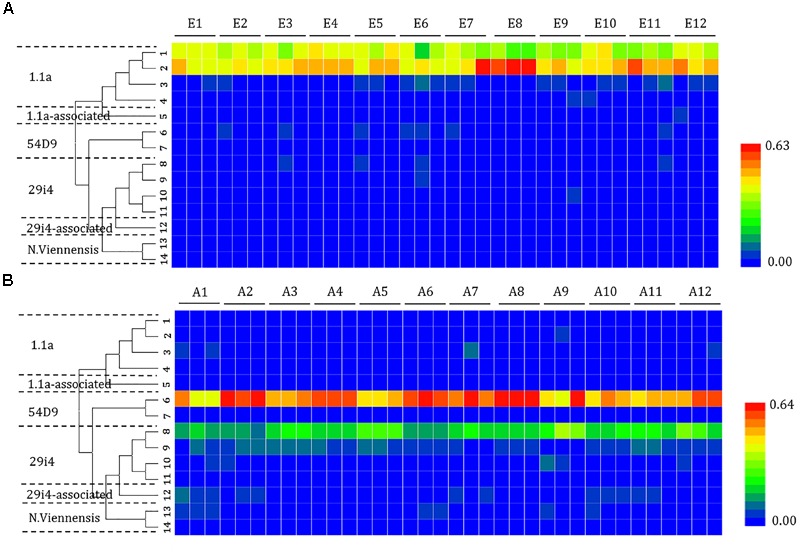
Heat map showing the relatedness of the ammonia-oxidizing archaea (AOA) community structures in the analysis of the (A) mudflat and (B) agricultural sites based on the relative abundance of distinct lineages of ammonia-oxidizing archaea 16S rRNA genes analyzed using pyrosequencing. The relative abundance of each lineage in each soil is displayed as a heat map representation. The phylogenetic position of each representative operational taxonomic unit is shown in the phylogenetic tree on the left-hand side.